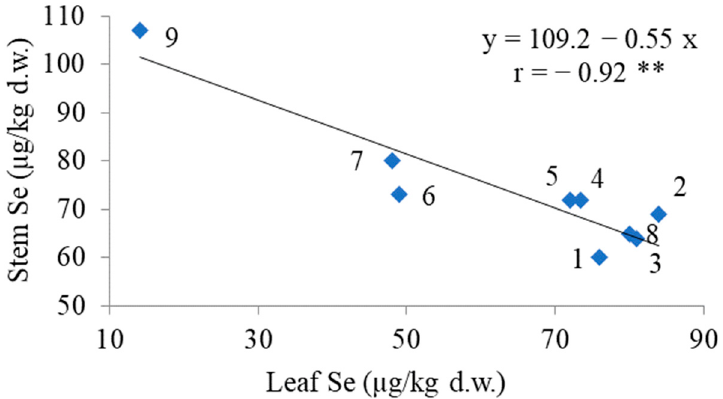
Figure 3. Correlation between leaf and stem selenium content in leek cultivars: (1) Cazimir, (2) Vesta, (3) Camus, (4) Kalambus, (5) Summer Breeze, (6) Giraffe, (7) Bandit, (8) Premier, (9) Goliath.